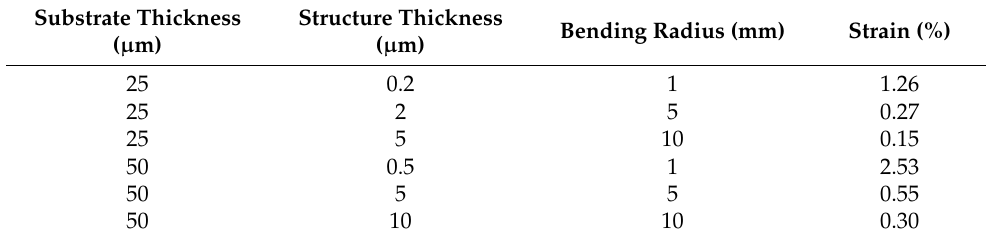
Table 2. Illustration of the strain based on defined combination of thicknesses and bending radii. Substrate